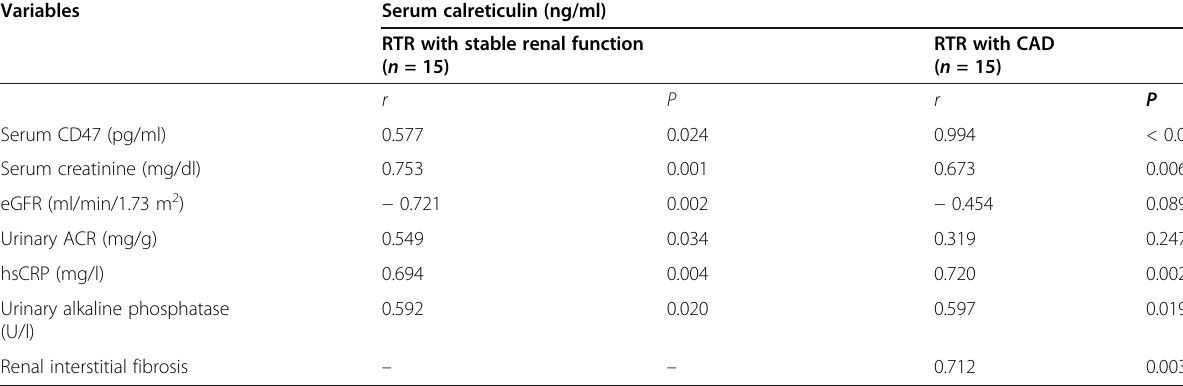
Table 2 Statistical correlations between serum calreticulin (CRT) levels (ng/ml) on the one hand and serum CD47, renal function, high-sensitivity C-reactive protein (hsCRP), urinary alkaline phosphatase, and degree of renal fibrosis on the other hand in renal transplant recipients (RTR) with stable renal function and chronic allograft dysfunction (CAD) Variables Serum calreticulin (ng/ml) RTR with stable renal function RTR with CAD ( n = 15) ( n = 15) Serum CD47 (pg/ml) < 0.001 Serum creatinine